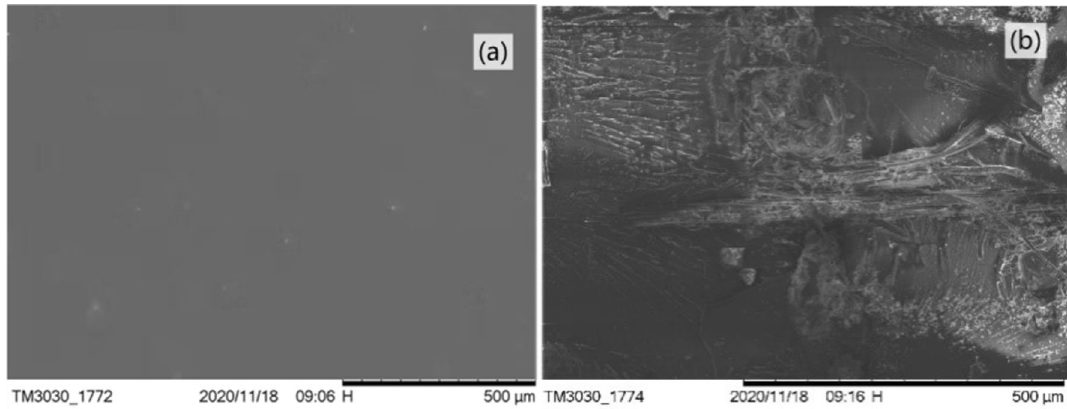
Figure 11. SEM image of impact fracture surface: ( a ) of pure E51; ( b ) of